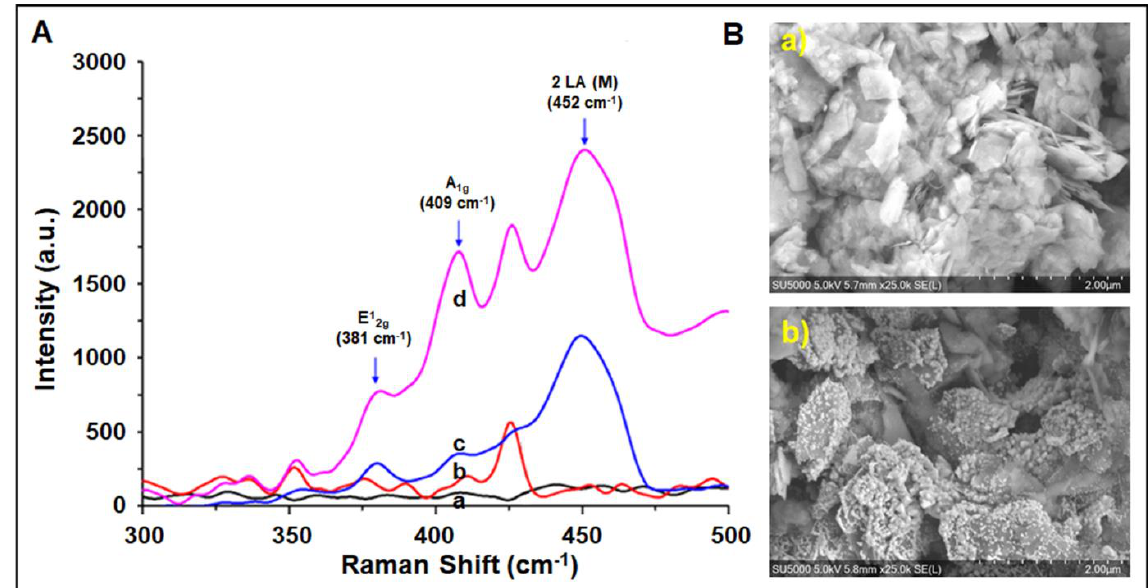
Figure 5. ( A ) Raman spectra of paper electrode: (a) nitrocellulose membrane (black), (b) carbon paste (red), (c) MoS 2 -modified paper electrode (blue), (d) MoS 2 -modified paper electrode after AuNP deposition (red). ( B ) SEM images of (a) MoS 2 -nanosheet-modified paper electrode and (b) MoS 2 -modified paper electrode after gold electrodeposition (scale: 2 µm).